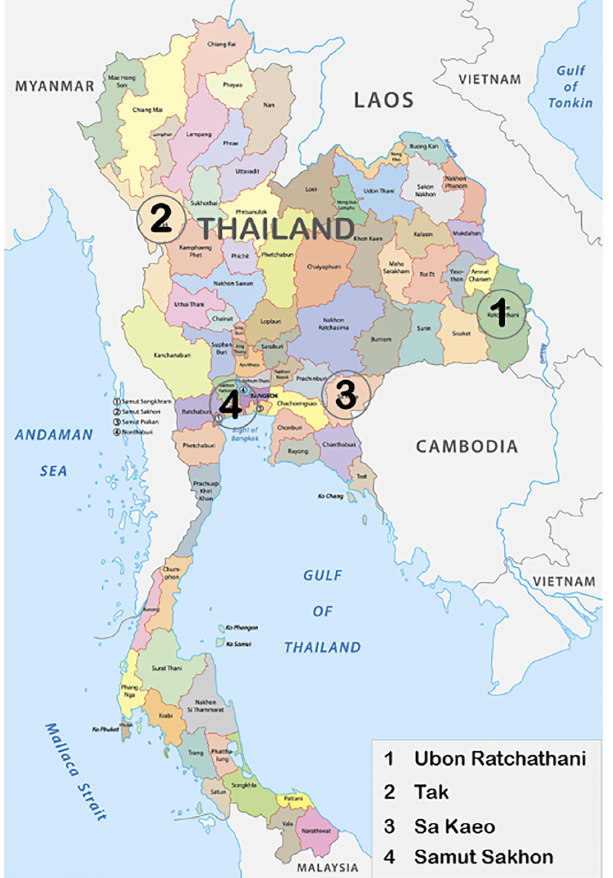
Figure 2. Four case